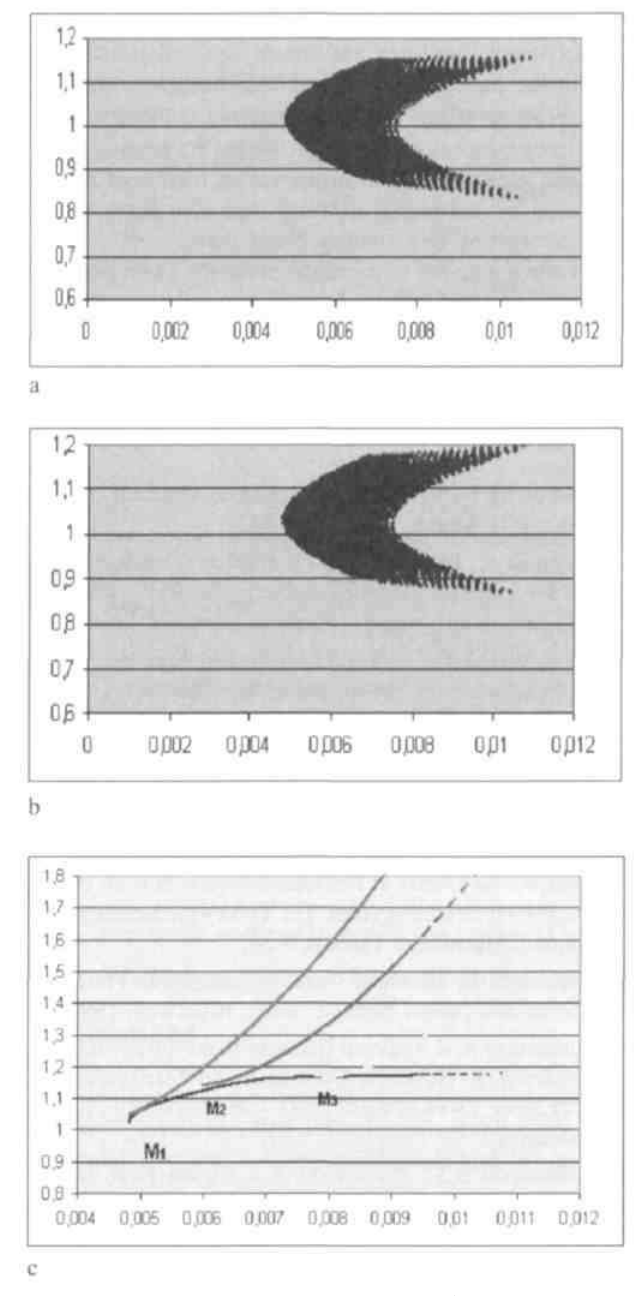
Fig 5. The fragment of four currencies (USD, JY, GBP, RUB) portfolio which maximize accumulated sum: a, b the subsets of portfolios when they present consequently minimum and maximum profitability possibilities, if to take in account their depending on standard deviation; (cid:0) - optimal portfolios for three investments M,, M.,, M standard deviation-mean value